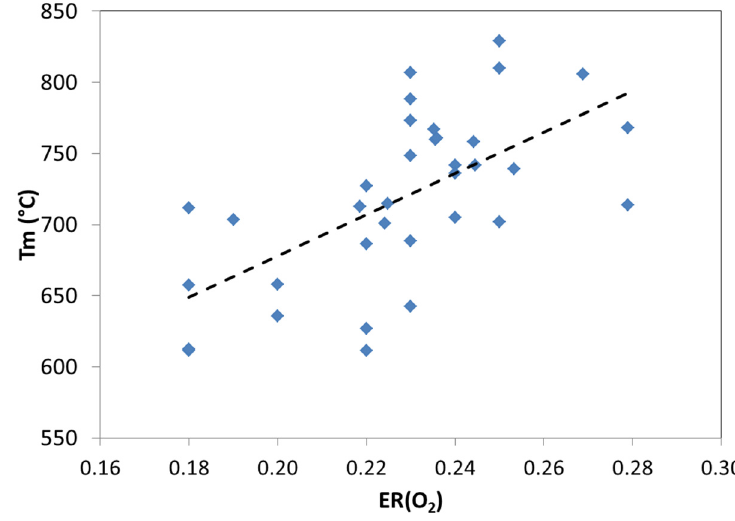
Figure 5. Average temperature in the reactive bed as function of the equivalence ratio ER(O 2 ).